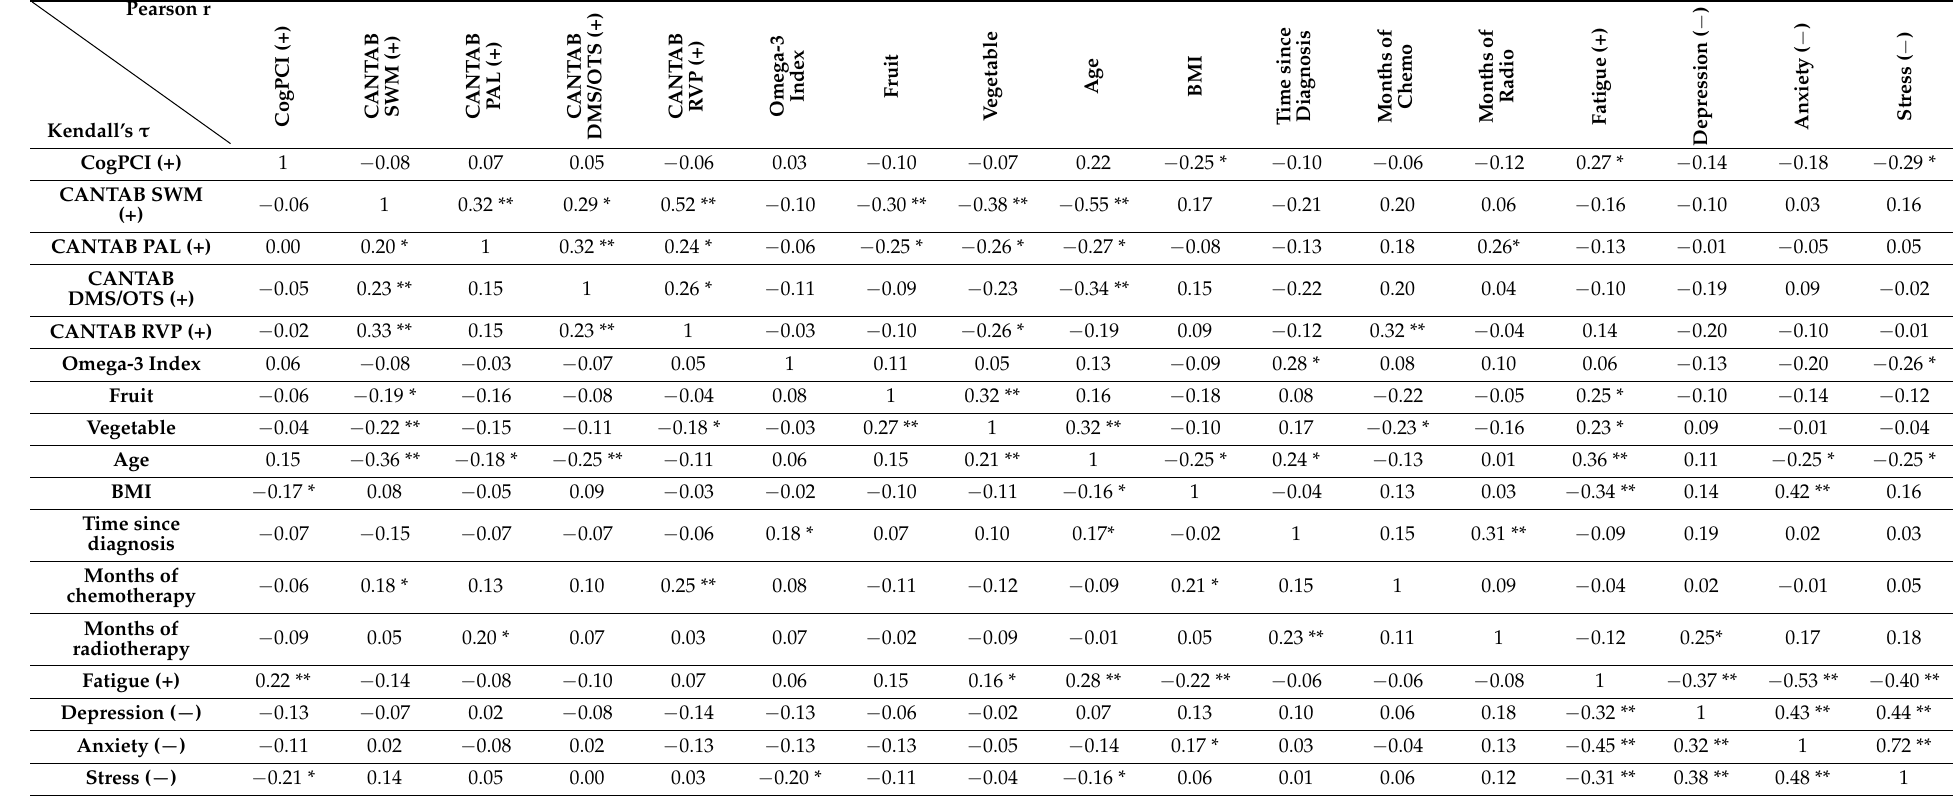
Table A4. Bivariate correlation matrix between demographic, diet, and cognitive